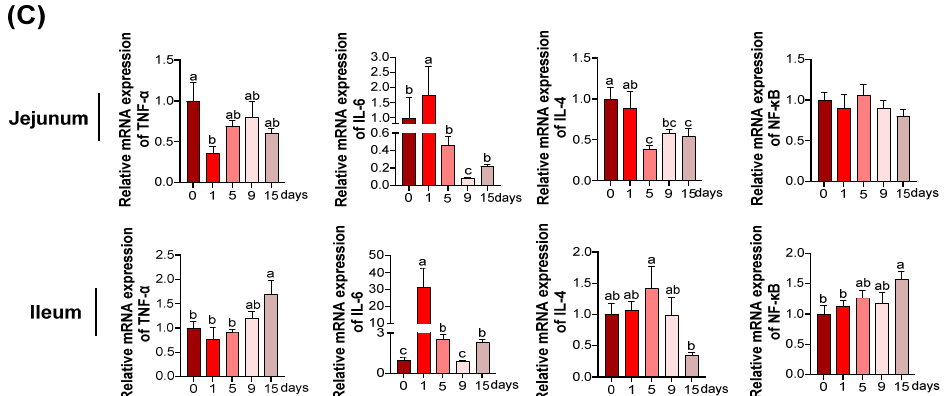
Figure 3. Intestinal epithelial inflammation under LPS-induced chronic immune stress: ( A , B ) representative images and quantification of CD3+ and CD68+-positive cells (A: jejunum; B: ileum); ( C ) the mRNA expression of inflammation related genes. The two end edges of the box correspond to inter quartile ranges of data, inside line represents the median, and the colored dot, squared, regular triangle, inverted triangle and diamond block in the figure correspond to the outliers for different days. n = 6 for each group. a,b,c Values within a row with different lowercase letters differ significantly ( p < 0.05) by the Duncan’s multiple comparisons. A,B,C Values within a row with different capital letters differ significantly ( p < 0.05) by the Kruskal–Wallis test. TNF- α , tumor necrosis factor- α ; IL-